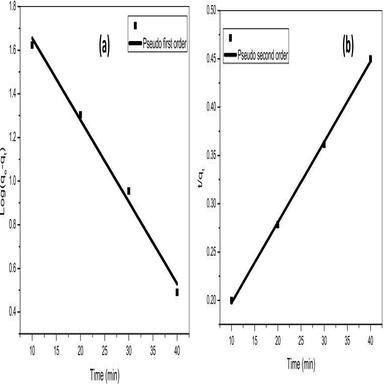
Kinetic modelling (a) pseudo1st order & (b) pseudo 2nd order fitting of Mo(VI) sorption onto.mesoporous (MnO2/MWCNTs) at 298 K, pH = 2, Co = 10 mmol L.− 1 .